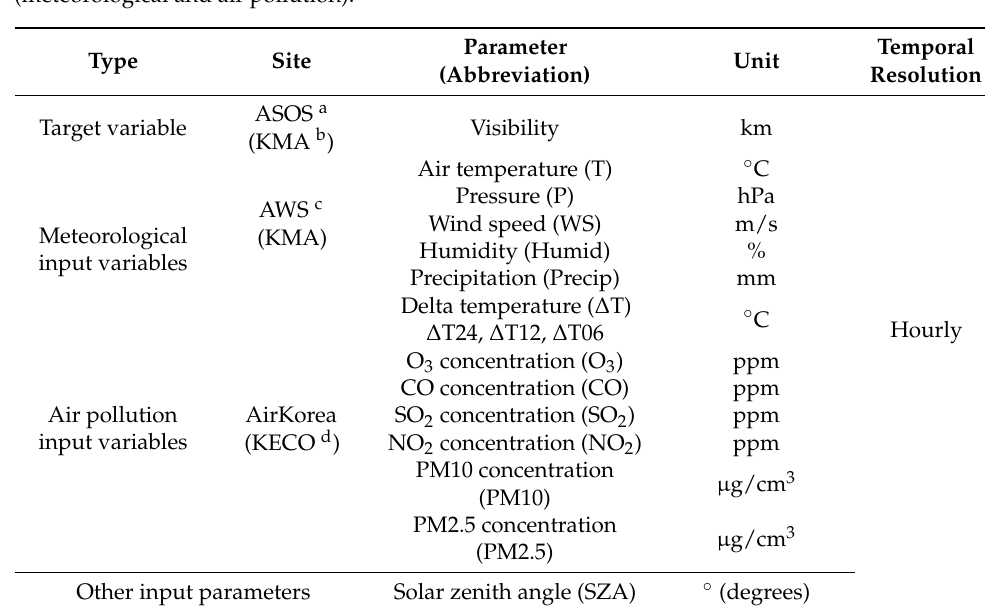
Figure 2. Locations of ( a ) ASOS, ( b ) AWS, and ( c ) AirKorea observation sites in South Korea. Table 1. Sites, units, and temporal resolutions of target variable (visibility) and input variables (meteorological and air pollution).